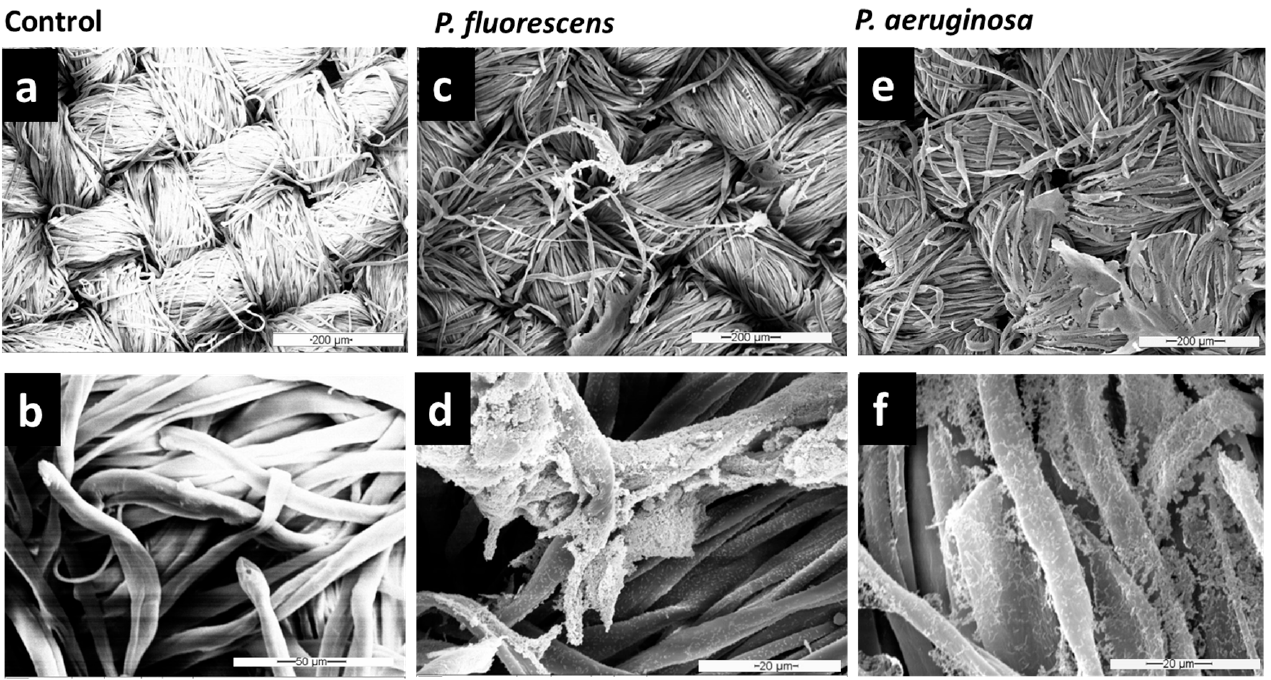
Figure 2. SEM images of autoclaved cellulose incubated with LB only (without bacteria) as control ( a , d ) and biofilm formation of P. fluorescens ( c , d ) and P. aeruginosa ( e , f ) grown for 48 h. Lower ( a , c , d ) and higher ( b , d , e ) magnifications are shown.